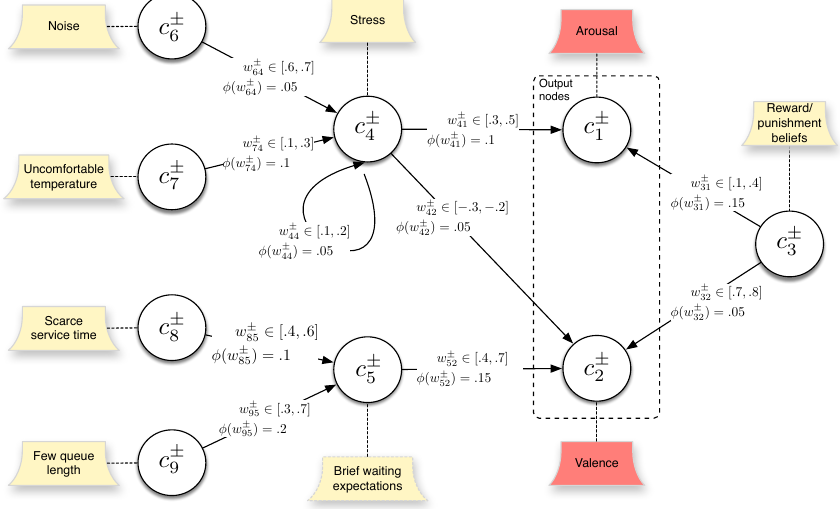
Figure 3. Fuzzy Cognitive Grey Map (FGCM)-based experimental